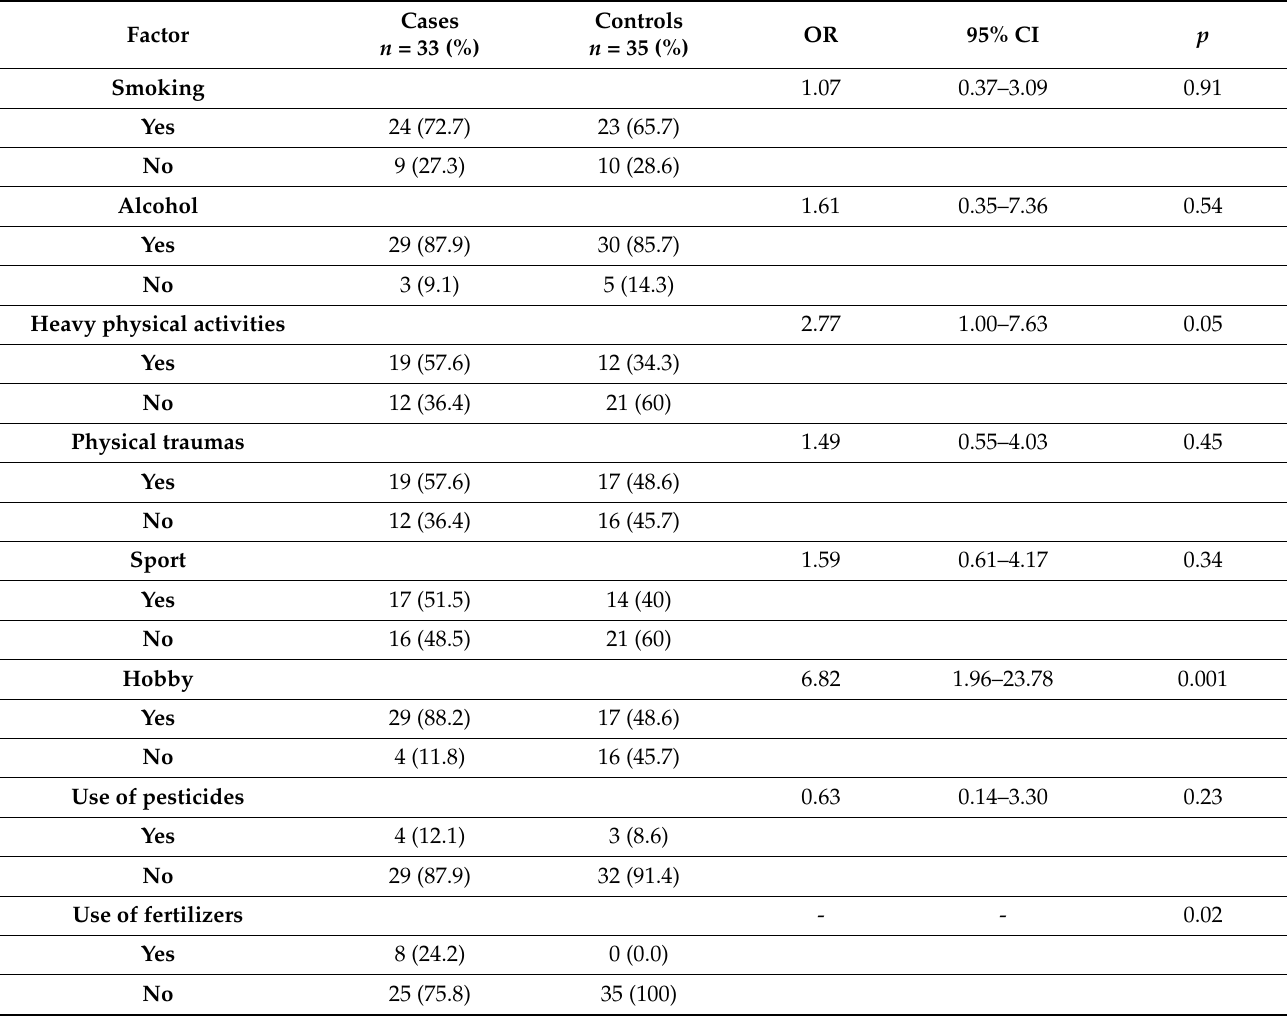
Table 2. Odds ratio (OR) with 95% confidence interval (95% CI) of ALS risk associated with lifestyle factors. Cases Factor n = 33 (%)